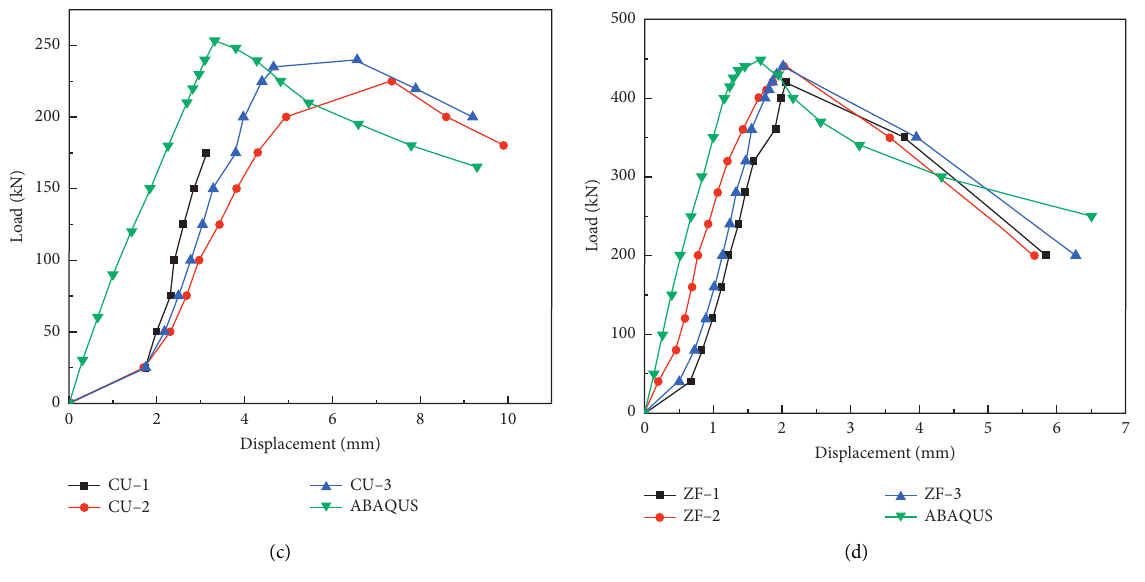
Figure 38: Comparison of load-displacement curves: (a) 4C type, (b) CU type, (c) CF type, and (d) ZF type.